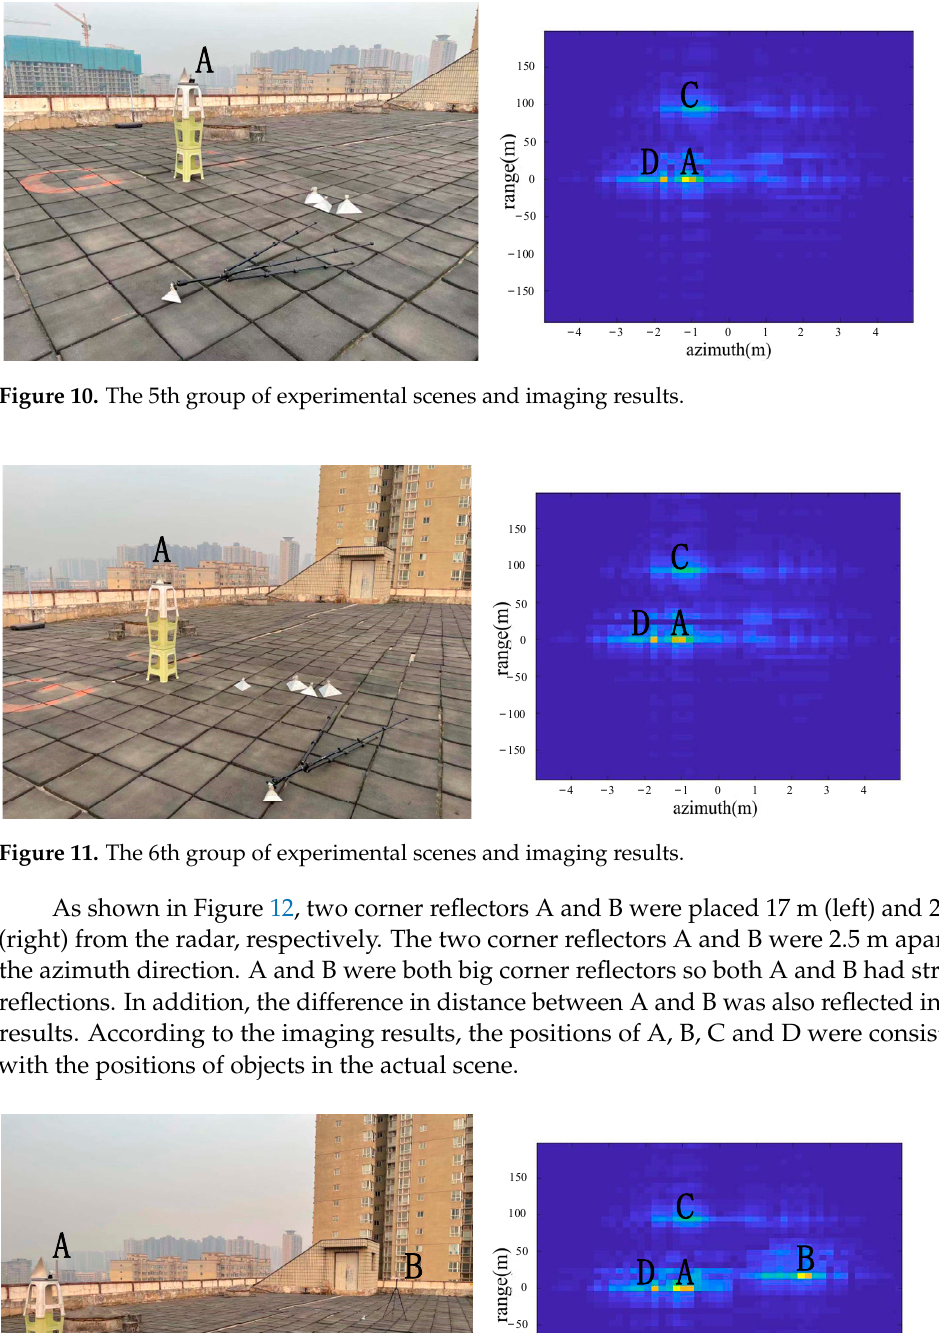
Figure 12. The 7th group of experimental scenes and imaging results.